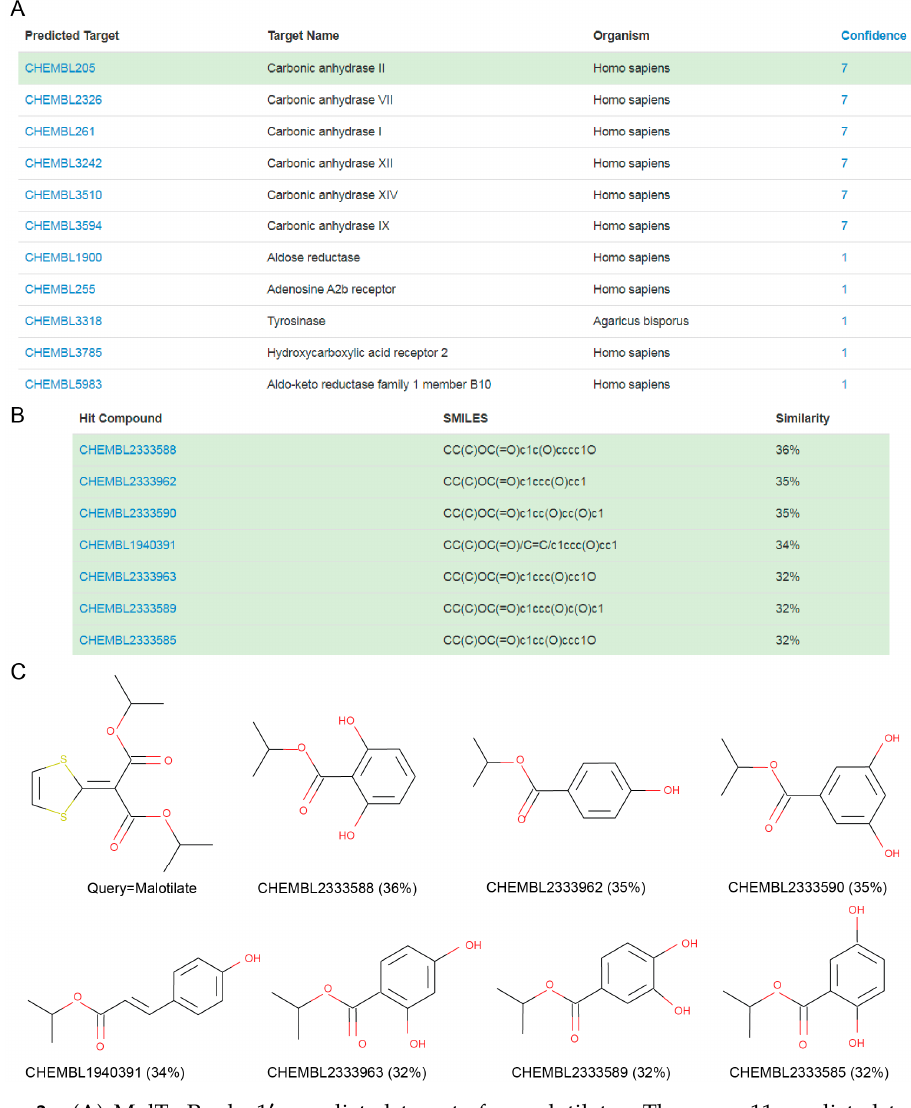
Figure 3. ( A ) MolTarPred v1’s predicted targets for malotilate. There are 11 predicted targets, one per row, sorted by decreasing reliability (confidence) score. CAII, highlighted in green, appears as a target of malotilate with a reliability score of 7. ( B ) SMILES and similarity scores of the seven top hits annotated with the inspected predicted target (CAII). ( C ) Chemical structures of the query molecule (malotilate; top left) and its seven CAII-annotated top hits listed in (B) to its right and bottom row.